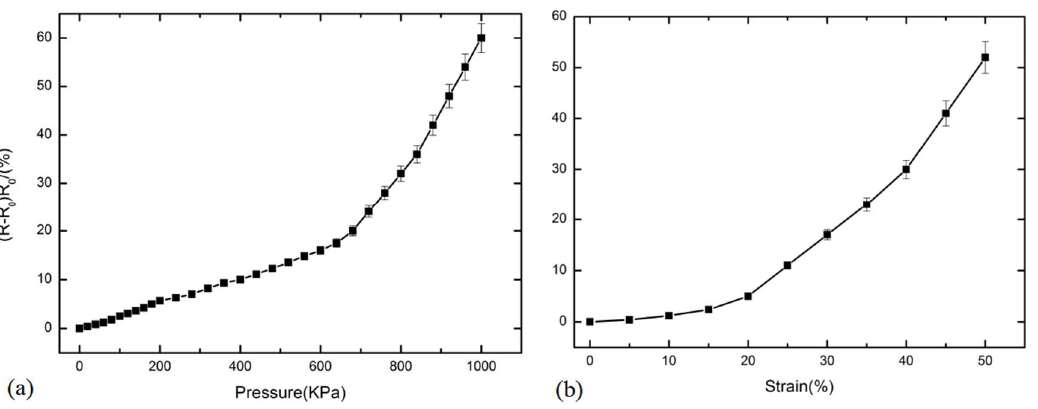
Figure 5. The relative resistance change of CNT/PDMS composites under ( a ) pressure and ( b ) tensile